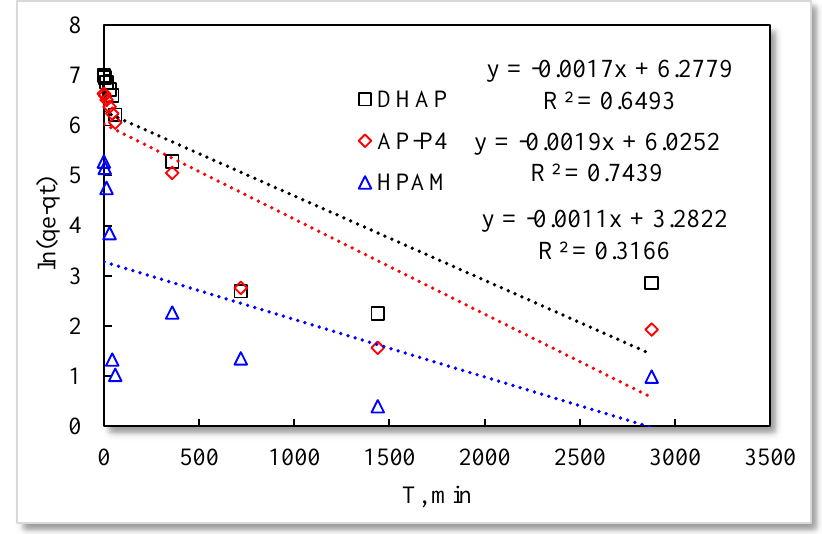
Figure 8. Elovich model.